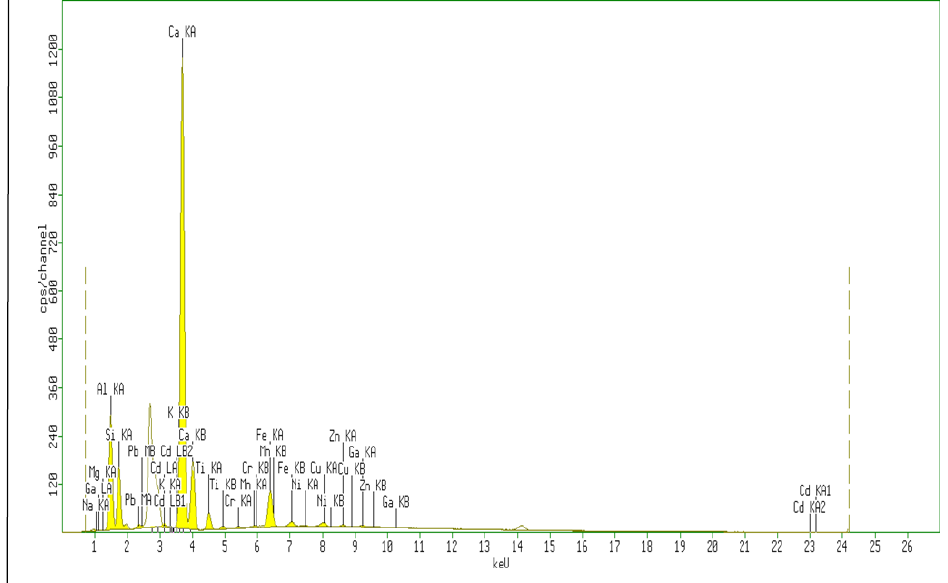
Figure 8 – XRF spectrum of a conductive fiber (with a sodium filter) Рис . 8 – Рентгенофлуоресцентный спектр провода ( с натриевым фильтром ) Слика 8 – XRF спектар проводљивог влакна ( са натријумским филтером